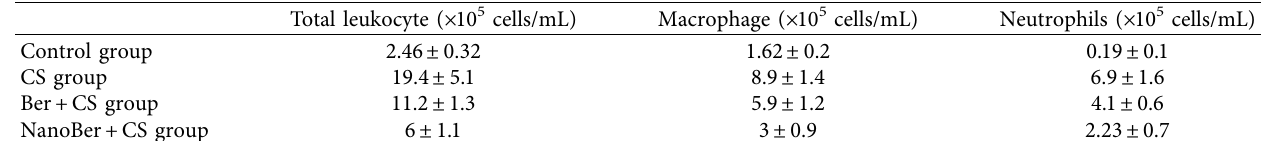
Table 3: Inflammatory cell counts in BALF.